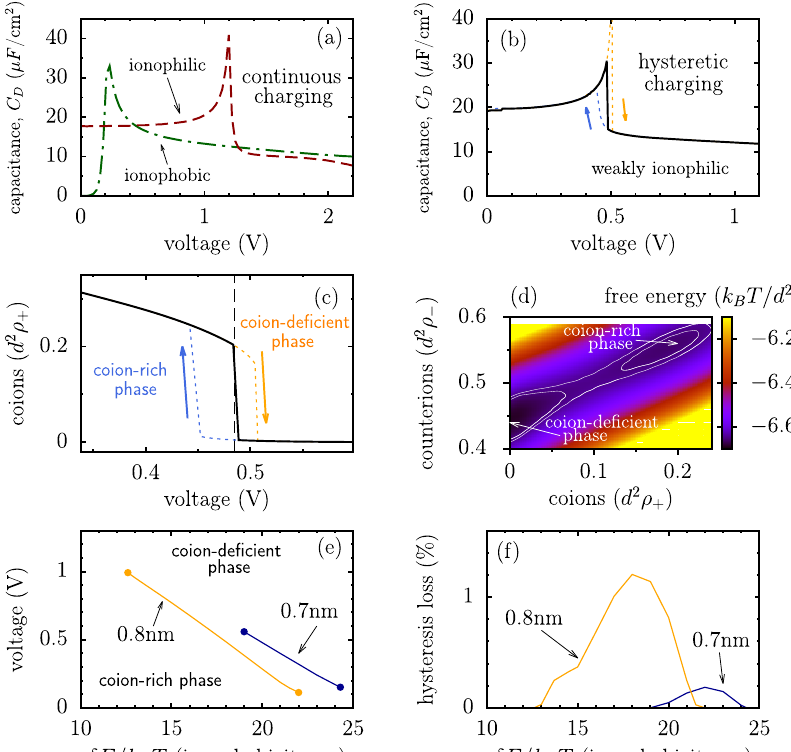
FIG. 6. Charging proceeds via a discontinuous phase transition for some parameter regimes. In all plots, ion diameter d ¼ 0 . 5 nm, and the mean-field theory is used to compute the thermodynamic properties. (a) Capacitance as a function of voltage in the continuous T and δ E ¼ 32 k T , respectively, and width charging regime. The ionophilic and ionophobic pores have resolvation energies δ E ¼ 10 k B B L ¼ 0 . 8 nm. (b) Capacitance as a function of voltage in the discontinuous charging regime. The solid curve indicates the minimum free- energy path, and the dotted curves denote the hysteresis loop with the arrows showing charging or discharging routes. The curve is T and L ¼ 0 . 8 nm. (c) Discontinuous charging is connected with an abrupt expulsion of coions. We identify here plotted for δ E ¼ 18 k B coion-deficient and coion-rich phases with vanishing and appreciable amounts of coions in the pore, respectively. The arrows show charging and discharging paths, which follow the metastable branches denoted by dotted lines, with the solid curve giving the minimum ≈ 0 . 49 volts at which the two phases have the same free energy path, as in panel (b). The vertical dashed line marks a voltage V coex energy and coexist. (d) The free-energy landscape for applied voltage V corresponding to the dashed line in panel (c). White lines are coex a contour plot of constant free energy, and the arrows point to the ion densities that simultaneously minimize the free energy at coexistence. The contour plot has been obtained by evaluating the free energy for given densities of cations and anions using Eq. (3). (e) The phase diagram plotted for different slit widths. (f) The percentage of energy that is lost because of hysteresis during discharging of a nanopore charged at 1.3 volts (see Appendix A